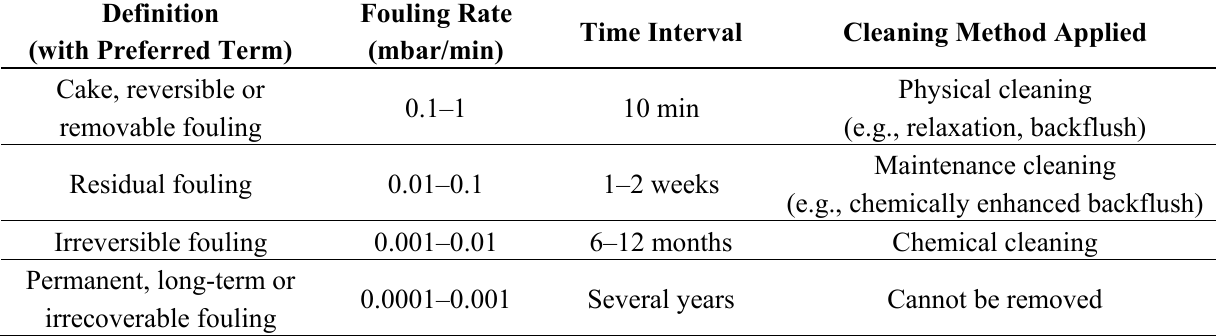
Table 2. Classification of fouling. Reproduced with permission from Reference